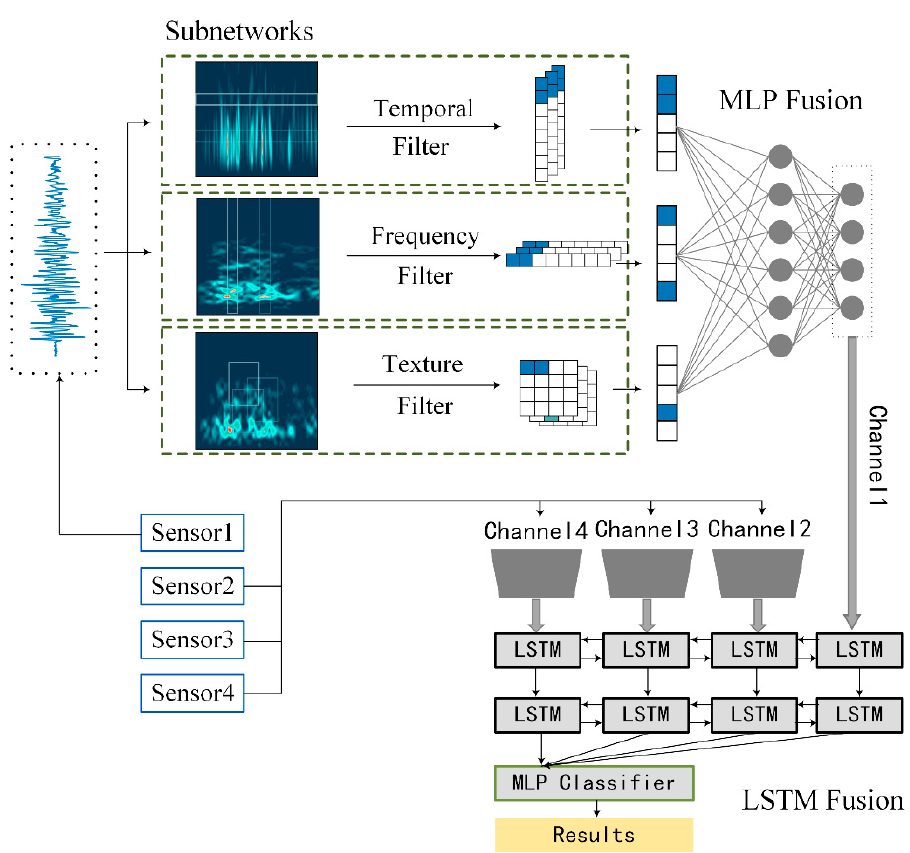
Figure 4. Structure of the multi-resolution CNN and the LSTM fusion.